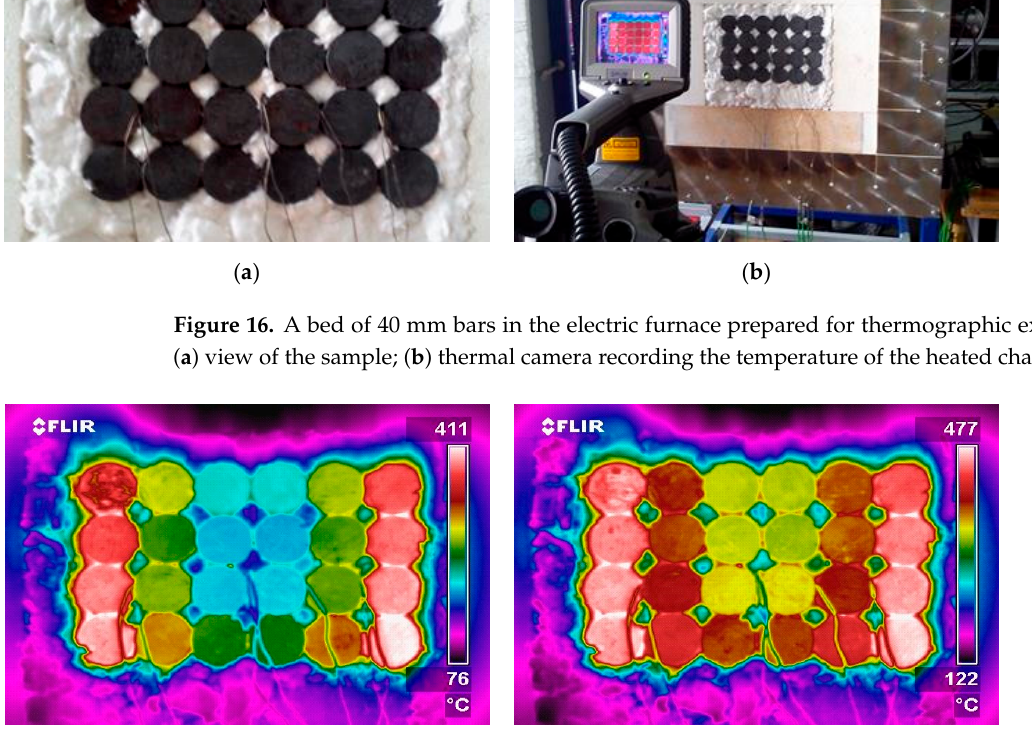
Figure 17. Selected thermograms recorded during heating of the charge presented in Figure